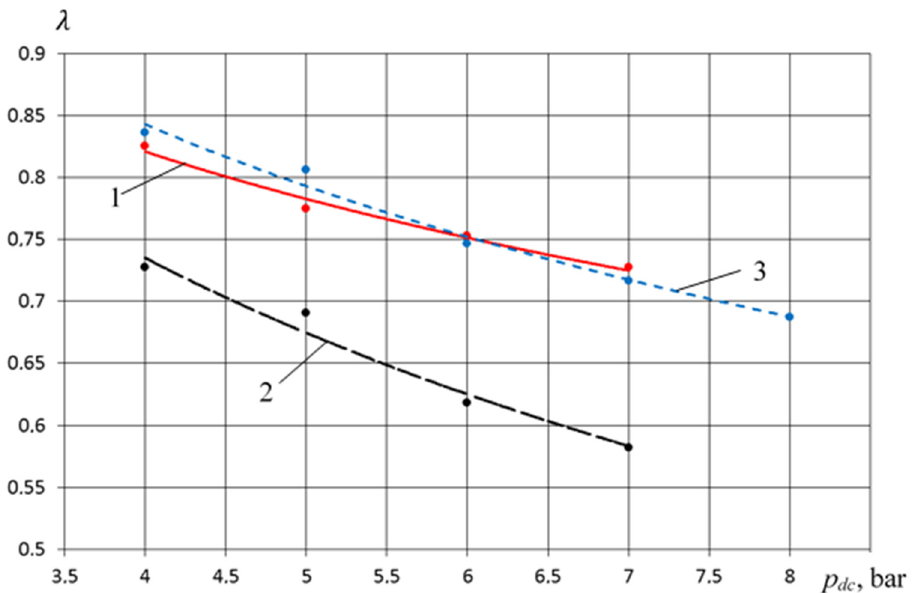
Figure 33. Dependence of the supply coefficient of the compressor section on the discharge pressure of the compressor section (1—PHPM with step-type gap seals; 2—PHPM with smooth gap seals; 3—Crosshead-free PHPM).